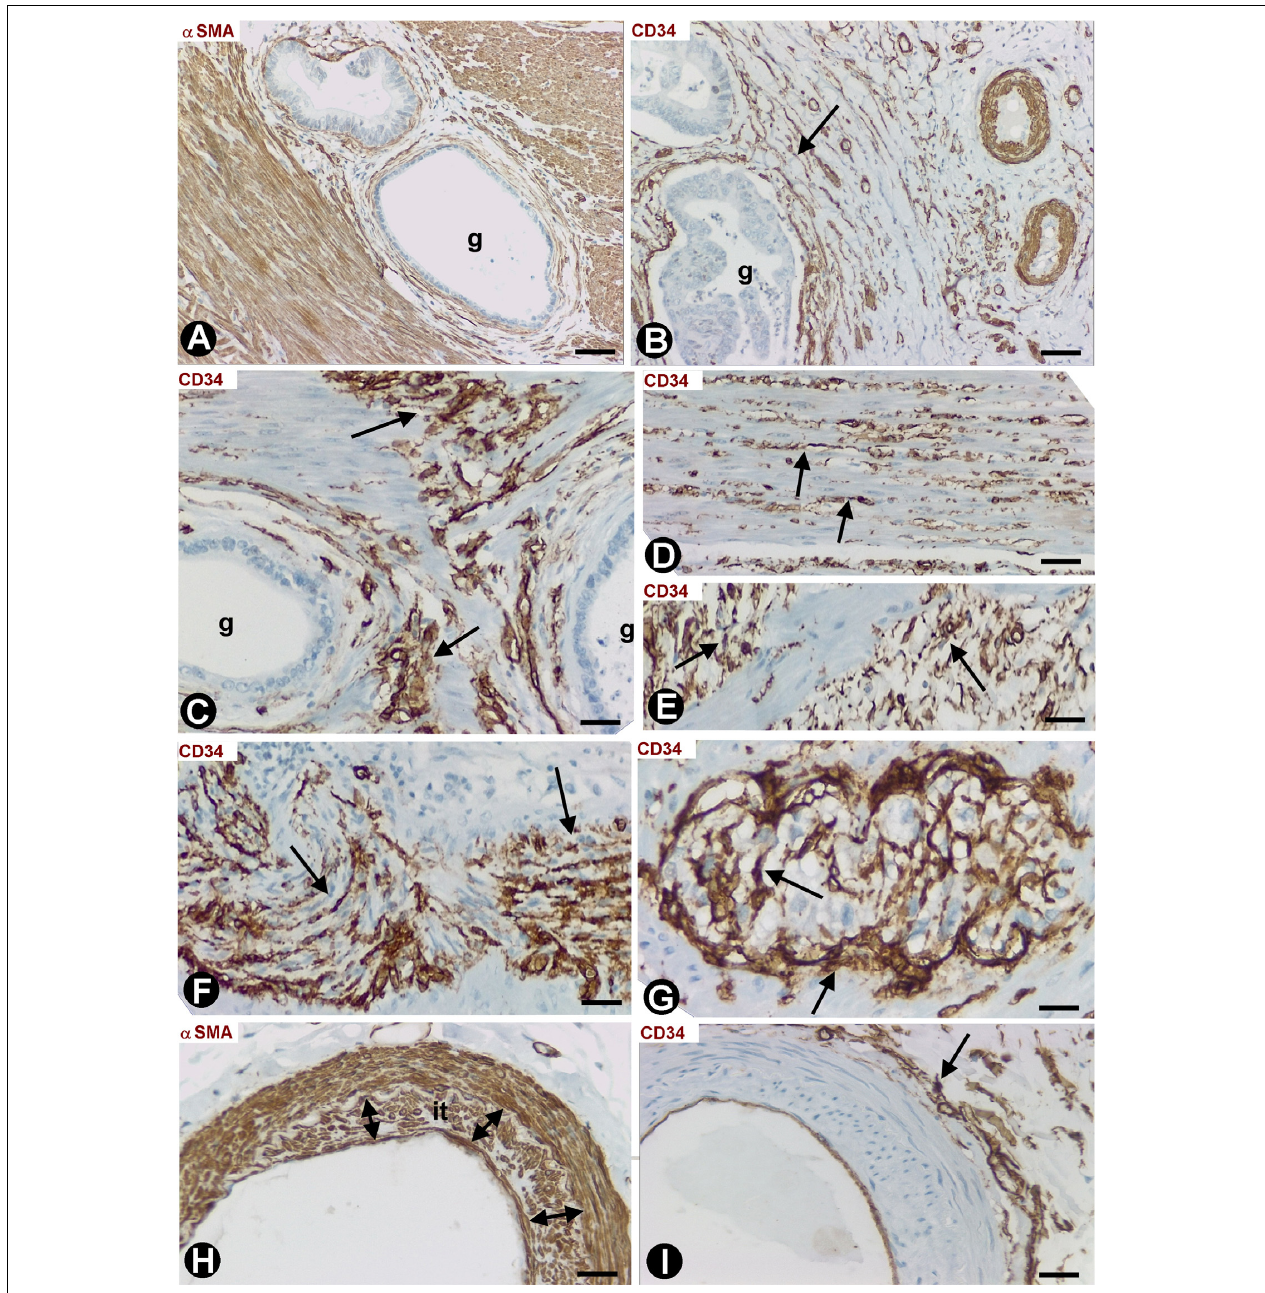
FIGURE 7 | Stromal cells in infiltrative carcinomas of colon. (A,H) Sections stained with anti- α SMA. (B–G,I) Sections stained with anti-CD34. (A) Scarce α SMA+stromal cells (arrow) around neoplastic glands (g) present in the connective tracts between the muscle fascicles of the muscularis propria. (B,C) Activated CD34+SCs/TCs (brown, arrow) neighboring neoplastic glands (g) in the muscularis propria. (D–G) activated CD34+SCs/TCs within ( D , arrow) and between ( E , arrow) muscle fascicles, a nerve (brown, arrow) and a myenteric plexus (brown, arrow). (H) Intimal thickening formed by α SMA+ cells is observed in an artery of the serosa. (I) Adventitial CD34+SCs/TCs (brown, arrow) are seen in an artery with intimal thickening. Bar: (A–F,H,I) 20 µ m; (G) 10 µ m.